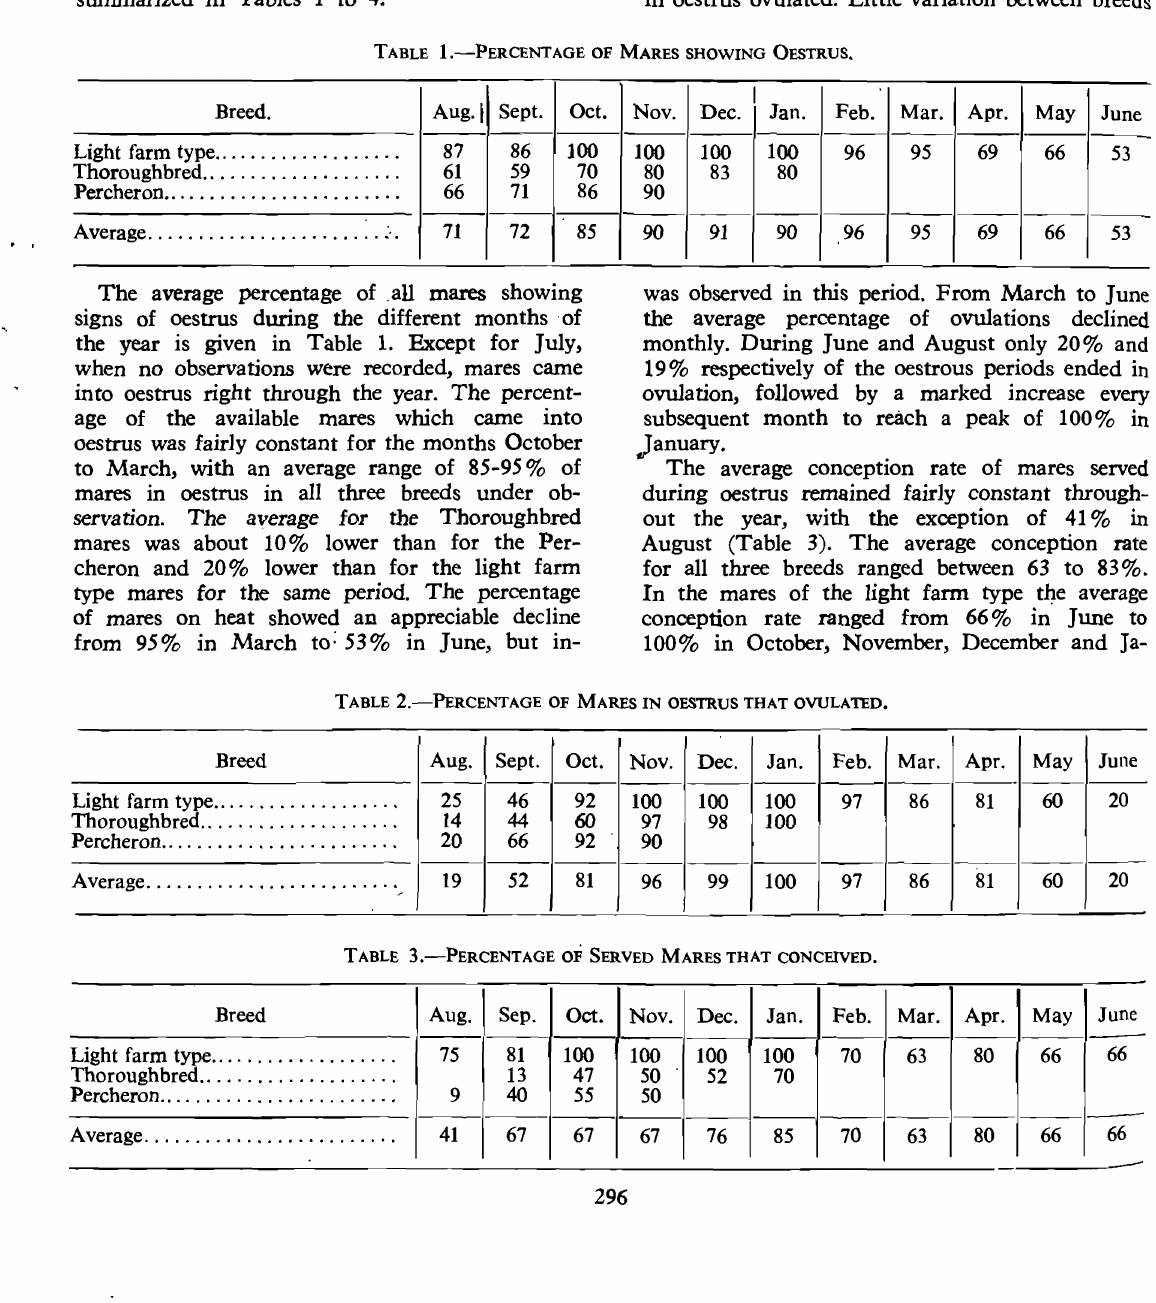
TABLE 3.-PERCENTAGE of SERVED MARES THAT CONCEIVED.